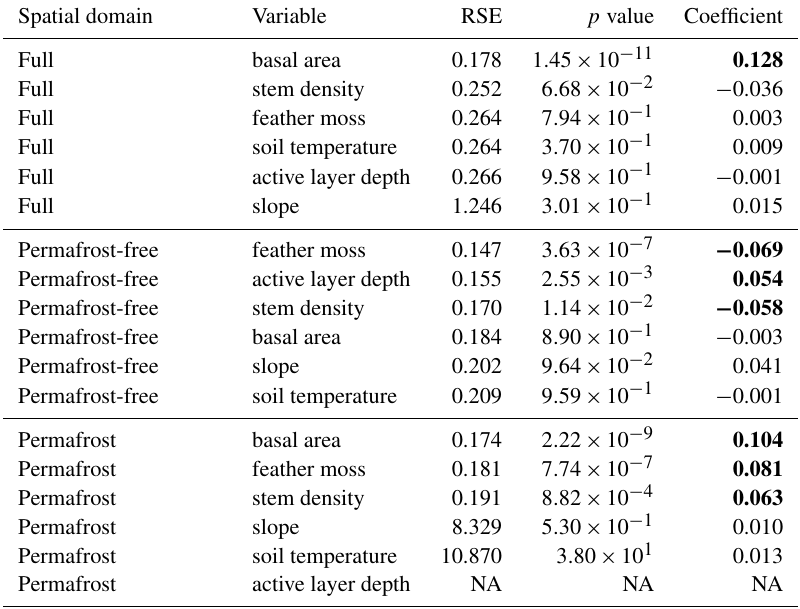
Figure 5. Interpolated soil respiration across seasons and spatial scales. Each panel has its own color ramp, and in all panels the values are CO 2 flux rates (gm − 2 h − 1 ). The vertical and horizontal axes in all panels indicate the south-to-north and west-to-east dimensions, respec- tively. The top panels show interpolations across the full spatial domain and the bottom panels show interpolations within the permafrost-free (P-f) and permafrost-associated (P-a) domains. Stronger spatial structure in Summer is evident as is the non-linear decline in soil respiration near 36m, moving from west to east. Table 2. Generalized least squares model fits for Summer soil respiration. Spherical spatial structure was used for all model fits. Models are sorted by their residual standard error (RSE), used as a metric of model fit. Model significance is reported as a p value and regression coefficients associated with p < 0 . 05 are in bold. Models were fit after normalizing data as standard normal deviates whereby regression coefficients can be directly compared. Entries of “NA” indicate that no model could be